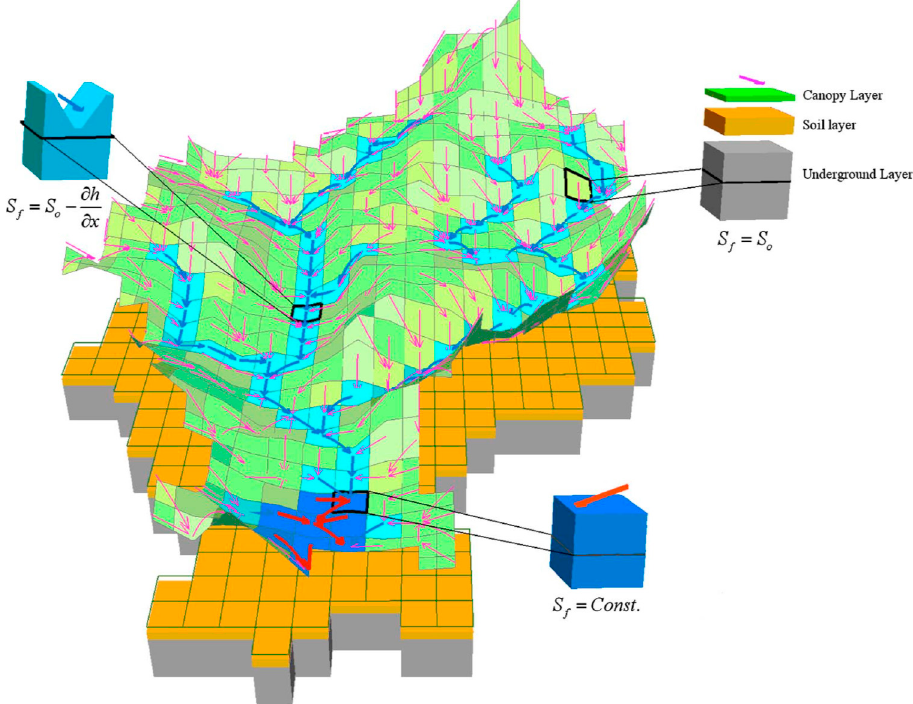
Figure 3. Liuxihe model structure (Chen et al., 2010) [24].